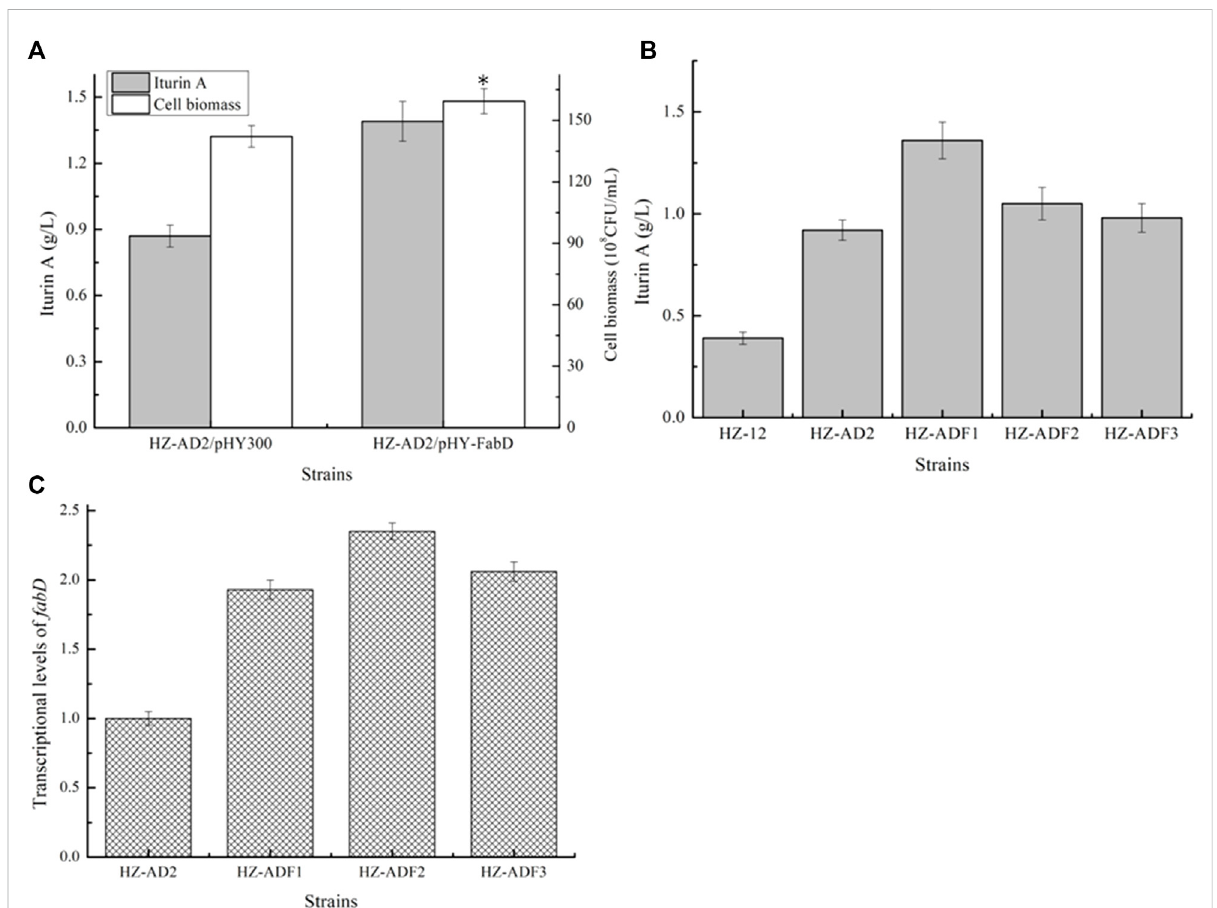
FIGURE 3 Effect of ACP S-malonyltransferase overexpression on iturin A production. (A) Effects of ACP S-malonyltransferase fabD overexpression on iturin A production. (B) Iturin A yields of fabD overexpression strains mediated by different promoters. (C) Transcriptional level analysis.